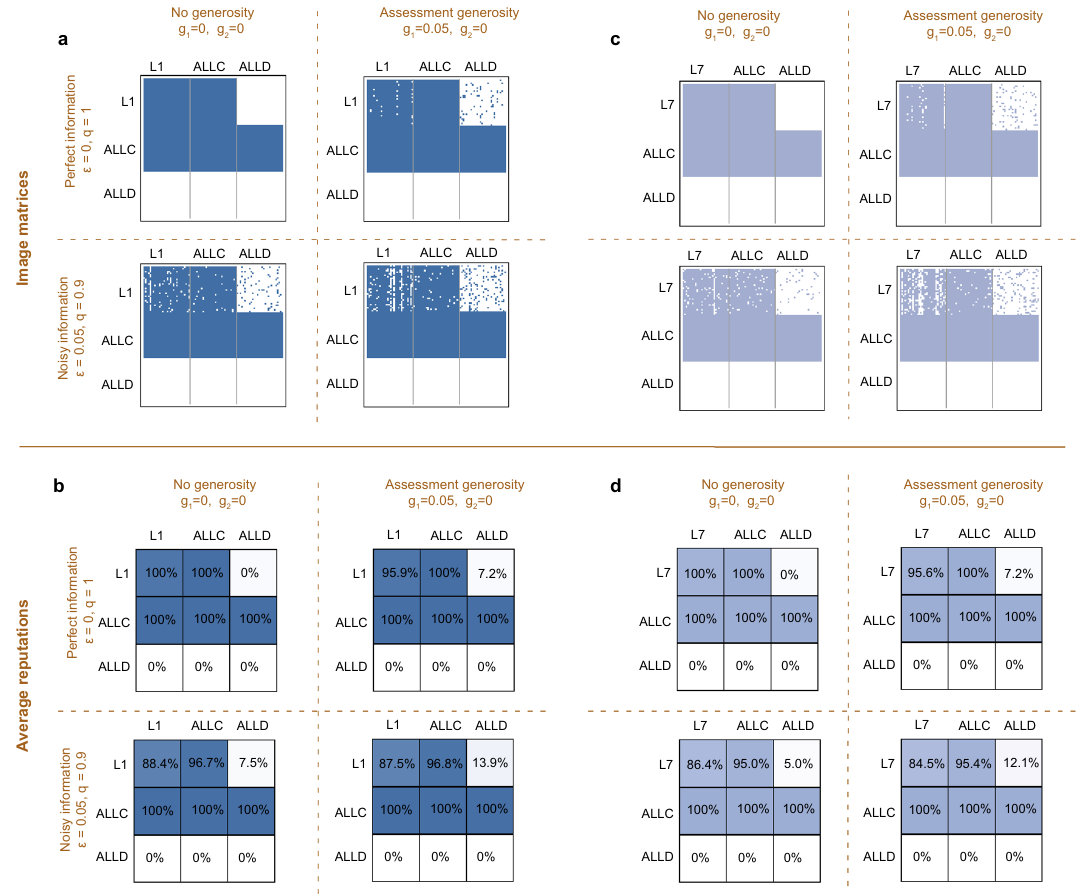
Figure 2. The effect of assessment generosity on the dynamics of reputations. ( a ) Image matrices are representations of how players assess each other at any given time. To depict these image matrices graphically, a colored dot means that the corresponding row player attributes a good image to the corresponding column player. Here, we show snapshots of such image matrices when players either use the leading-eight social norm L 1 , ALLC , or ALLD (in equal proportions). We consider four scenarios. These scenarios differ in whether information is perfect or noisy, and in whether or not L 1 players are generous. When information is perfect and there is no generosity, we observe that the reputation assignments of different L 1 players are perfectly correlated. If one L 1 player assigns a good reputation to some other group member, then so does every other L 1 player. In contrast, the presence of either noise or generosity introduces disagreements among L 1 players. ( b ) Here, we show the average image players have of one another. Generosity makes L 1 players perceive each other less favorably, and it makes them perceive ALLD players more favorably, irrespective of whether information is perfect or noisy. ( c , d ) We observe similar patterns for all other leading eight social norms. Here we illustrate the competition between L 7 , ALLC , and ALLD . Parameters: We use a population of size N = 90 , an error rate of either ε = 0 or ε = 0.05 , and a generosity probability of either g 1 = 0 or g 1 = 0.05 . Simulations are run for 2 · 10 iterations, and the initial image matrix assumes a good reputation for all